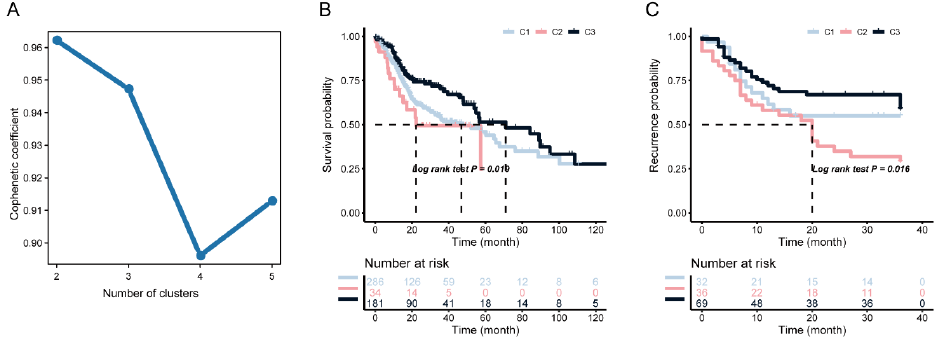
Figure 3. NMF consensus clustering identifies potential immune subtypes in HNSC. ( A ) The cophenetic coefficient for NMF in TCGA, K = 2 – 5. Survival analysis of the immune subtypes in the TCGA cohort ( B ) and GEO cohort ( C ), respectively.